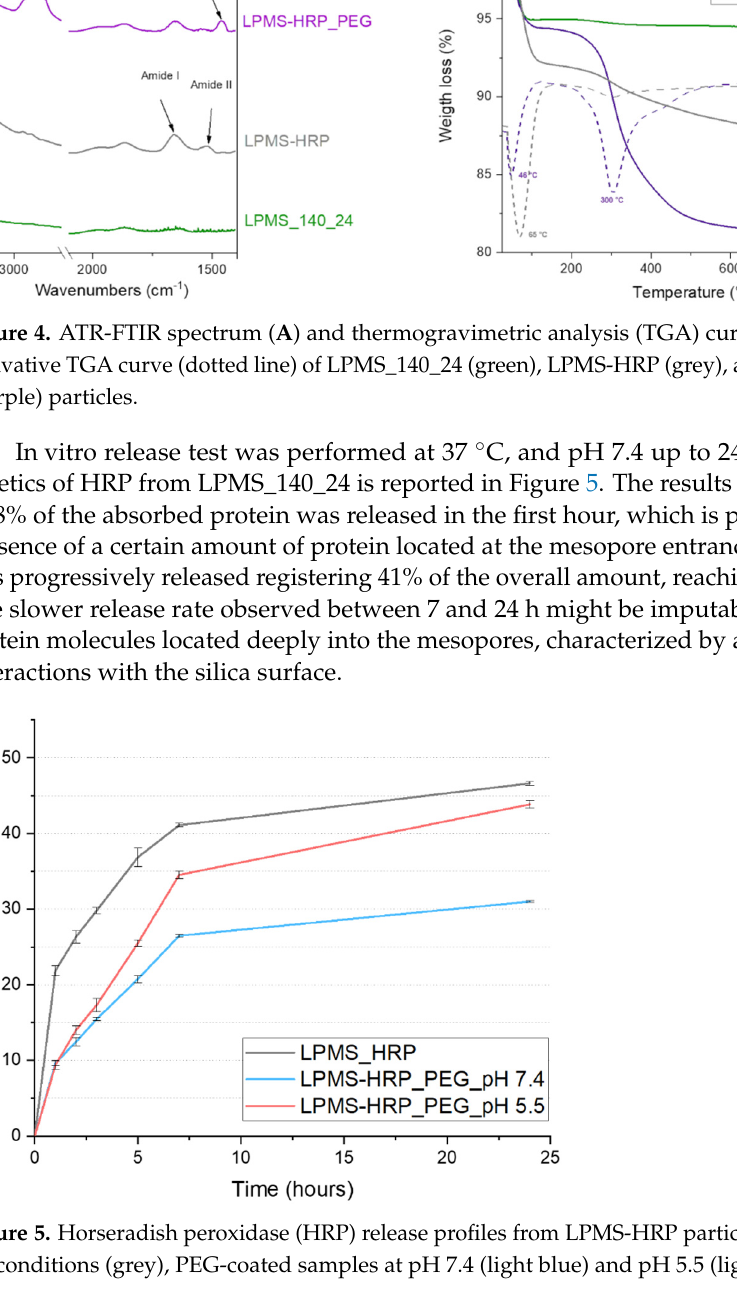
Figure 4. ATR-FTIR spectrum ( A ) and thermogravimetric analysis (TGA) curves ( B ) with relative derivative TGA curve (dotted line) of LPMS_140_24 (green), LPMS-HRP (grey), and LPMS- HRP_PEG (purple) particles.